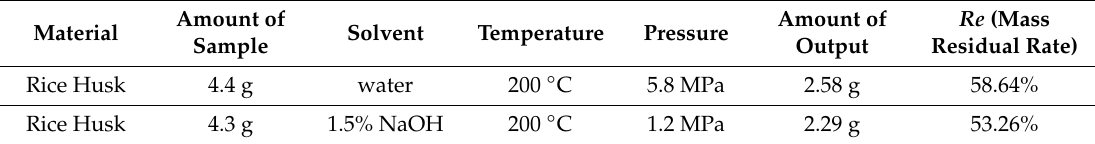
Table 4. Results of the hydrothermal treatment experiment.